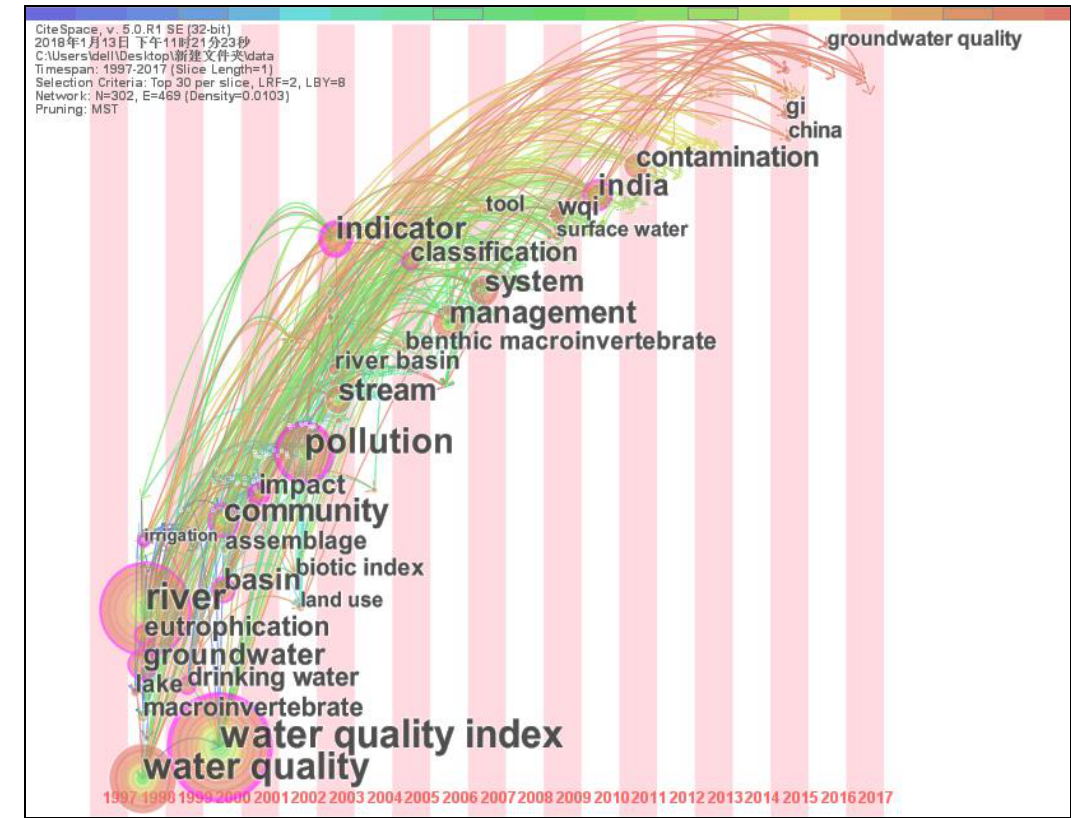
Figure 2. Time-zone view of keyword evolution